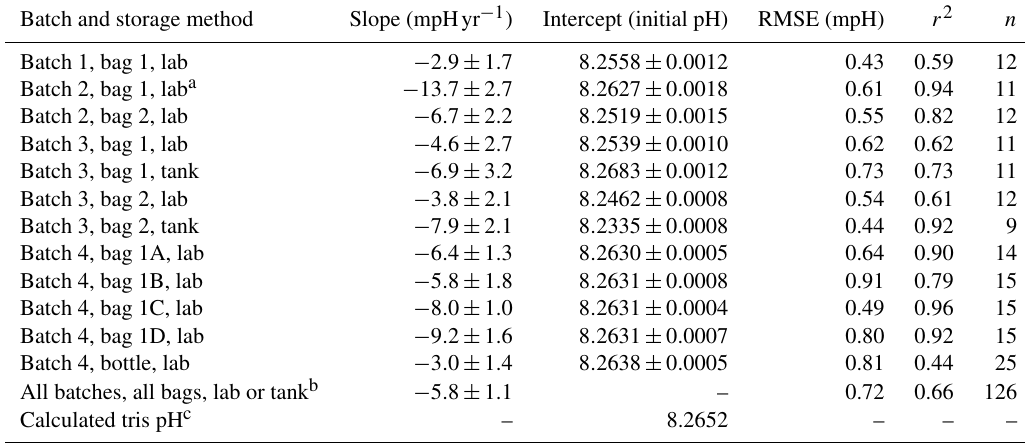
Table 2. Linear regression statistics from trend lines shown in Figs. 1 and 2. The last row shows the regression statistics for tris from all batches, in either bag type, stored in the lab or test tank. Slope and intercept are shown as mean ± 95% CI. The reported intercept is the regression intercept; when initial pH measurements are available, they differ by less than 0.0003 from regression intercept. Batch and storage method